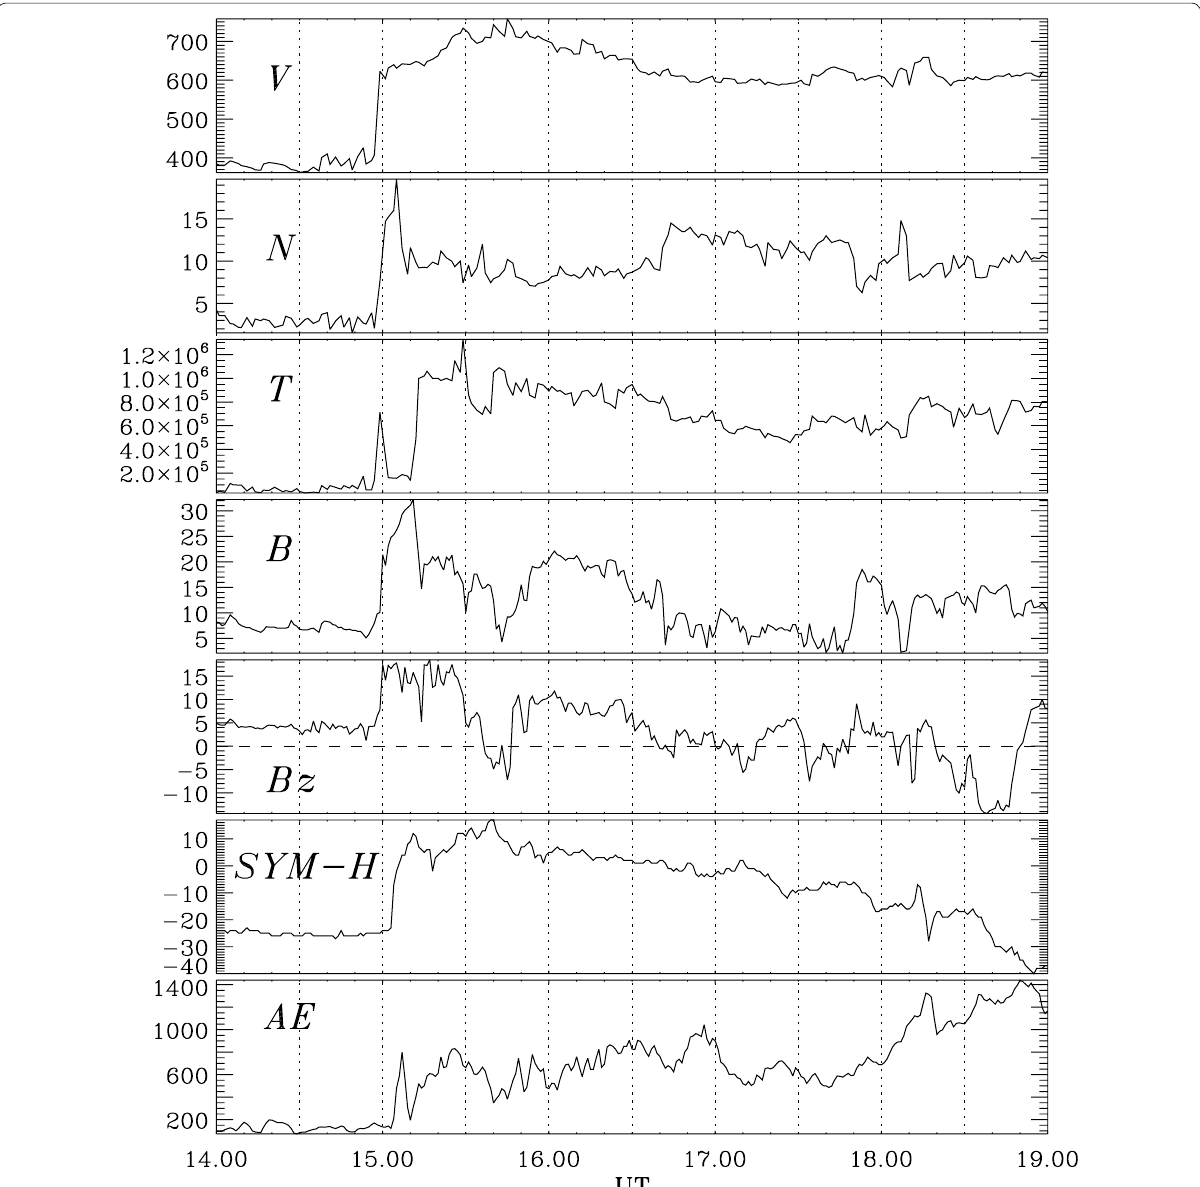
Fig. 1 The interplanetary shock detected on January 24, 2012, during time interval 1400–1900 UT by GEOTAIL: the solar wind velocity [ V x compo- nent (km/s)], solar wind density N (cm − 3 ), plasma temperature (K), IMF magnetic field magnitude B (nT) and component B z (nT), SYM-H index (nT), and AE index